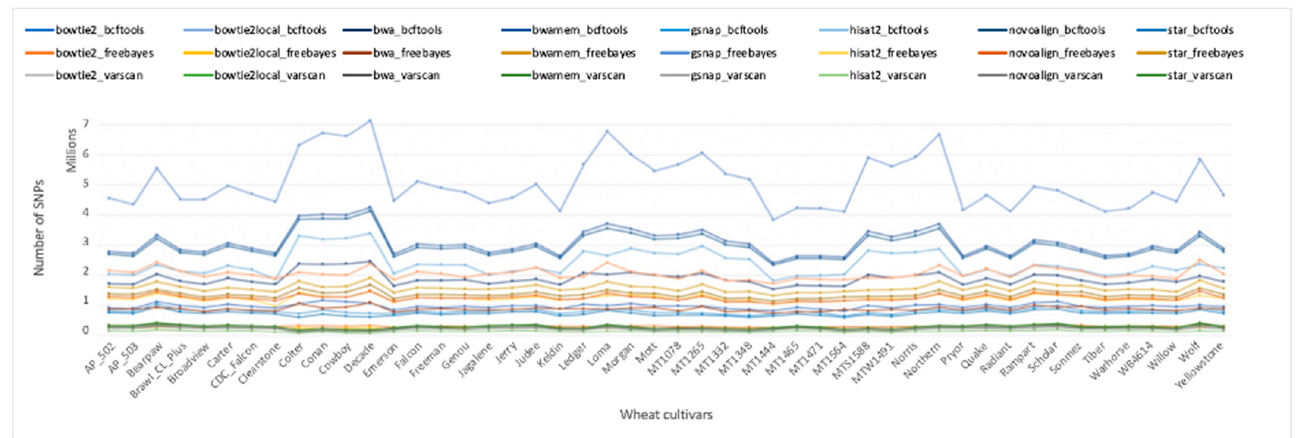
Figure 3. Number of SNPs called by 24 pipelines for 48 elite wheat cultivars. BCFtools pipelines were colored in blue, FreeBayes pipelines yellow/red, and VarScan pipelines in green/gray.